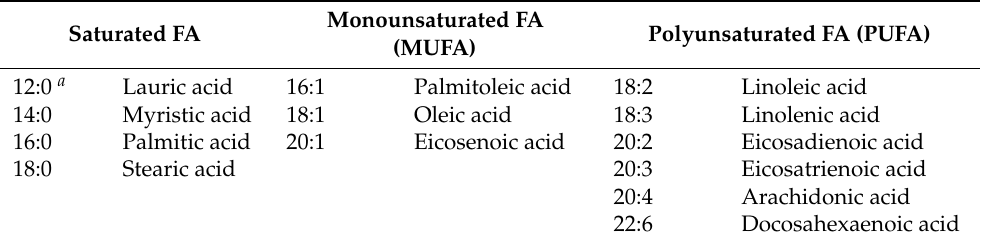
Table 1. Commonly reported FAs in lung tissue and lung surfactant [16,21].